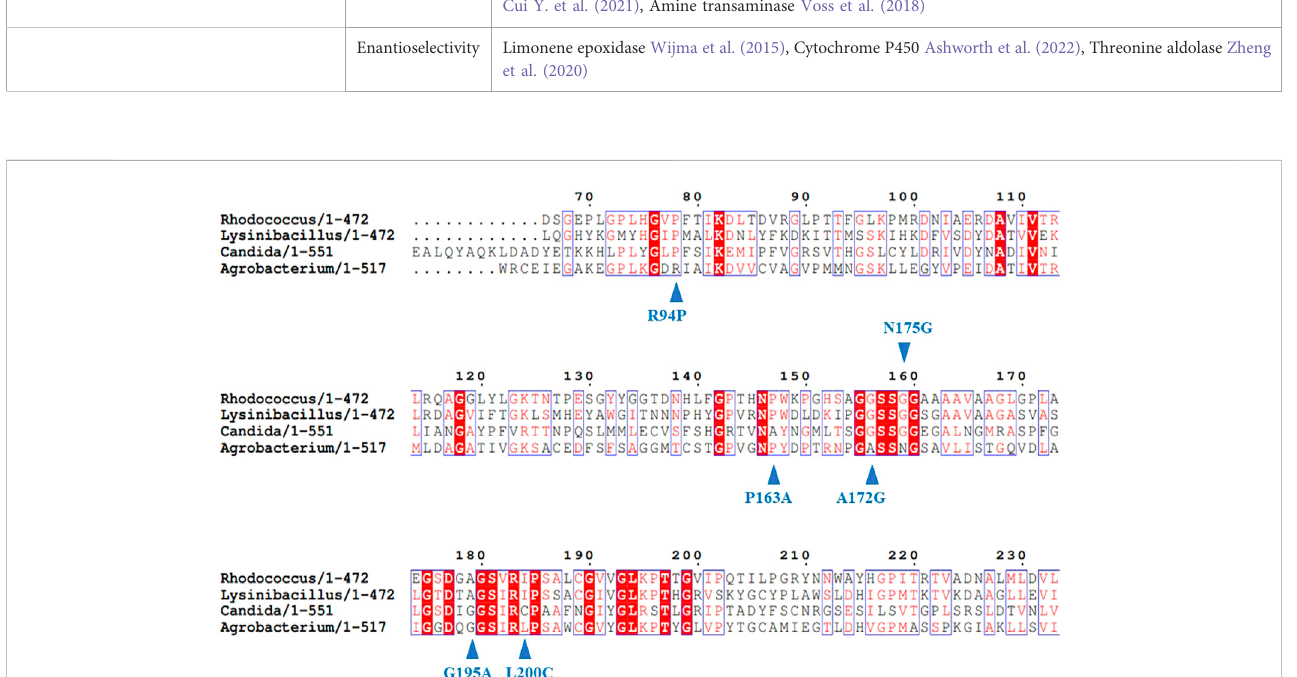
FIGURE 1 Design of mutations with improved activity using multiple sequence alignment for AmdA. Reprinted with permission from (Yao et al., 2022). Copyright 2022 ACS Publications Division.